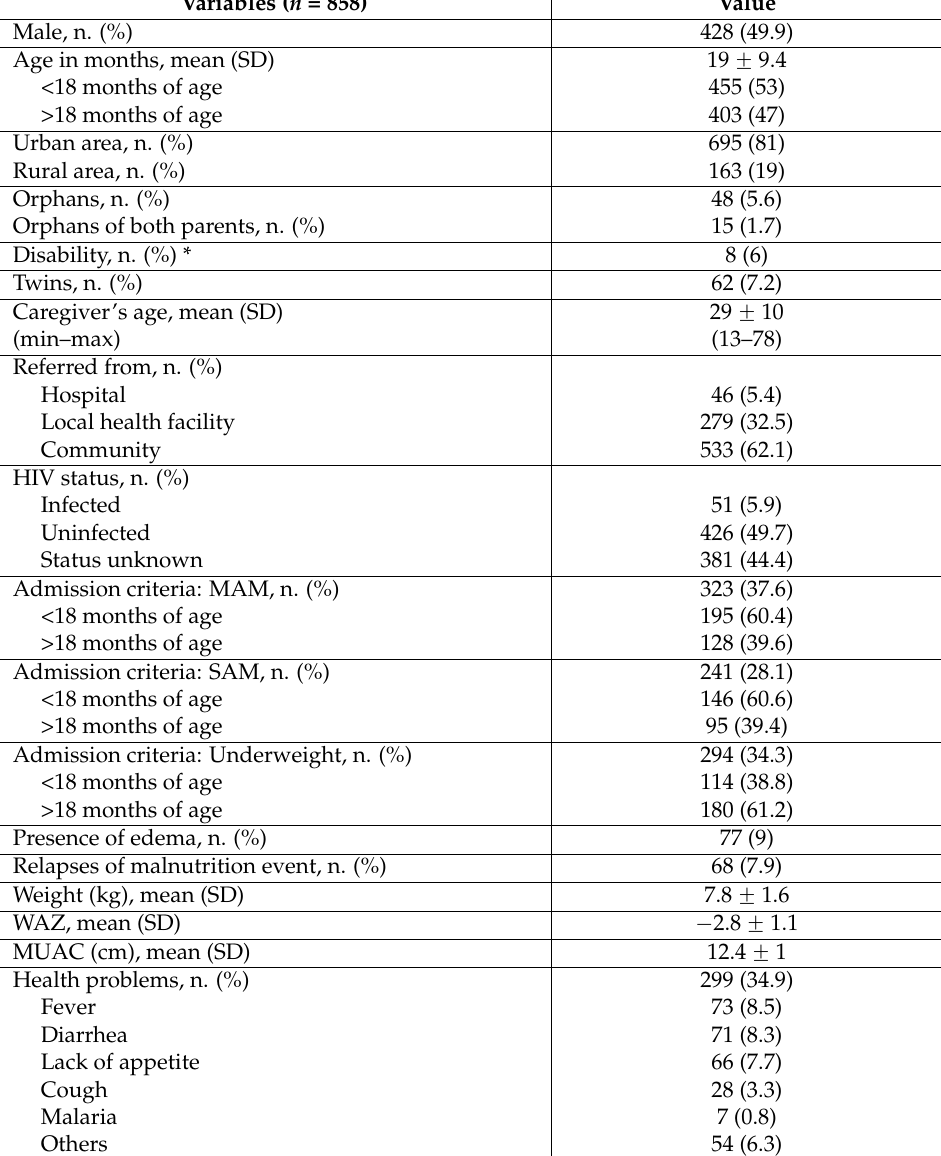
Table 1. Demographic, social, health, and nutritional characteristics of children at